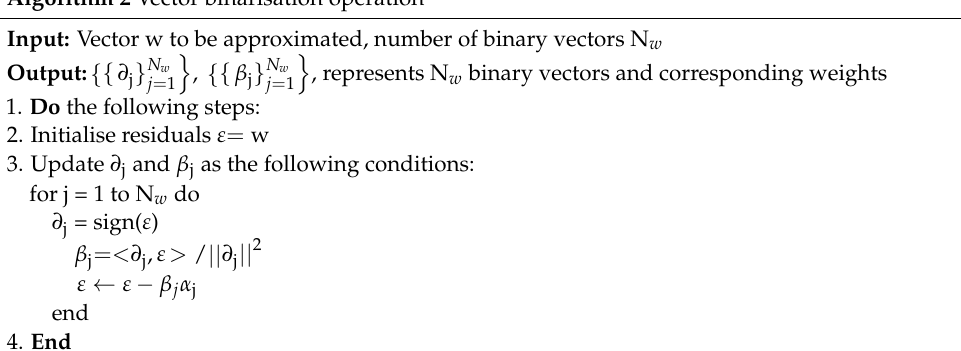
Figure 2. Diagram of image gradient operation: ( a ) Original image with target ship, ( b ) image with target after gradient operation, ( c ) original image with background, and ( d ) image with background after gradient operation. Algorithm 2 Vector binarisation